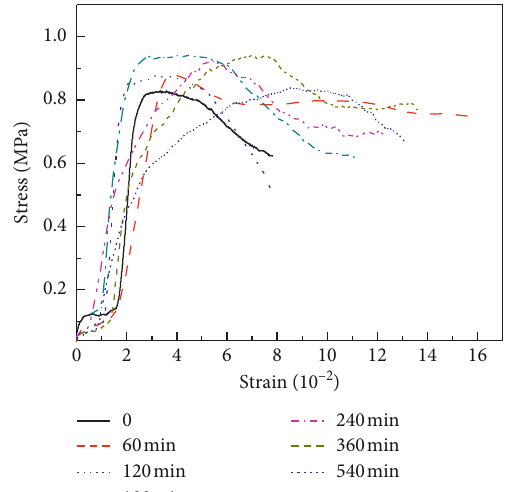
Figure 8: The change in the stress-strain curve of the samples after electrochemical modification with different power-on times.